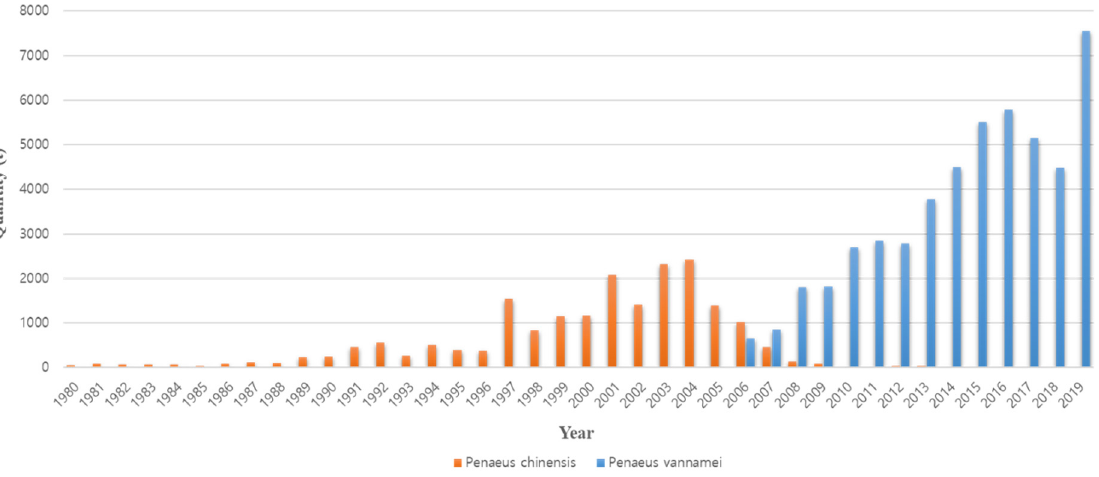
Figure 4. Total shrimp aquaculture production for Penaeus chinensis and Penaeus vannamei in the Republic of Korea from 1980 to 2019 (Source: FAO Global Aquaculture Production Statistics from FishstatJ Software for Fishery and Aquaculture Statistical Time Series).